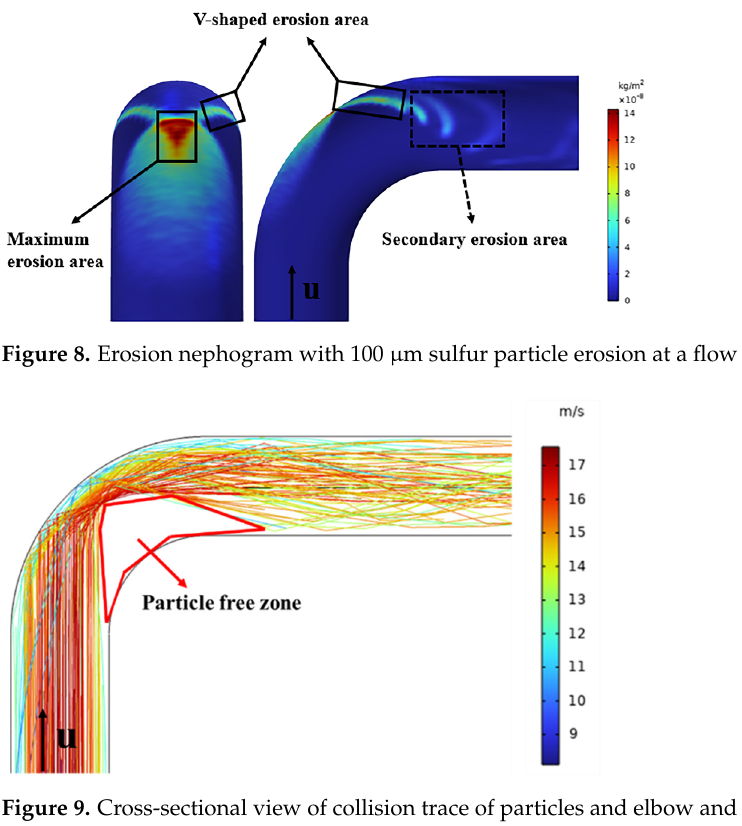
Figure 7. Equal cross ‐ sectional distribution of pressure and flow velocity at the elbow: ( a ) Sectional view of pressure distribution; ( b ) Sectional view of velocity distribution.